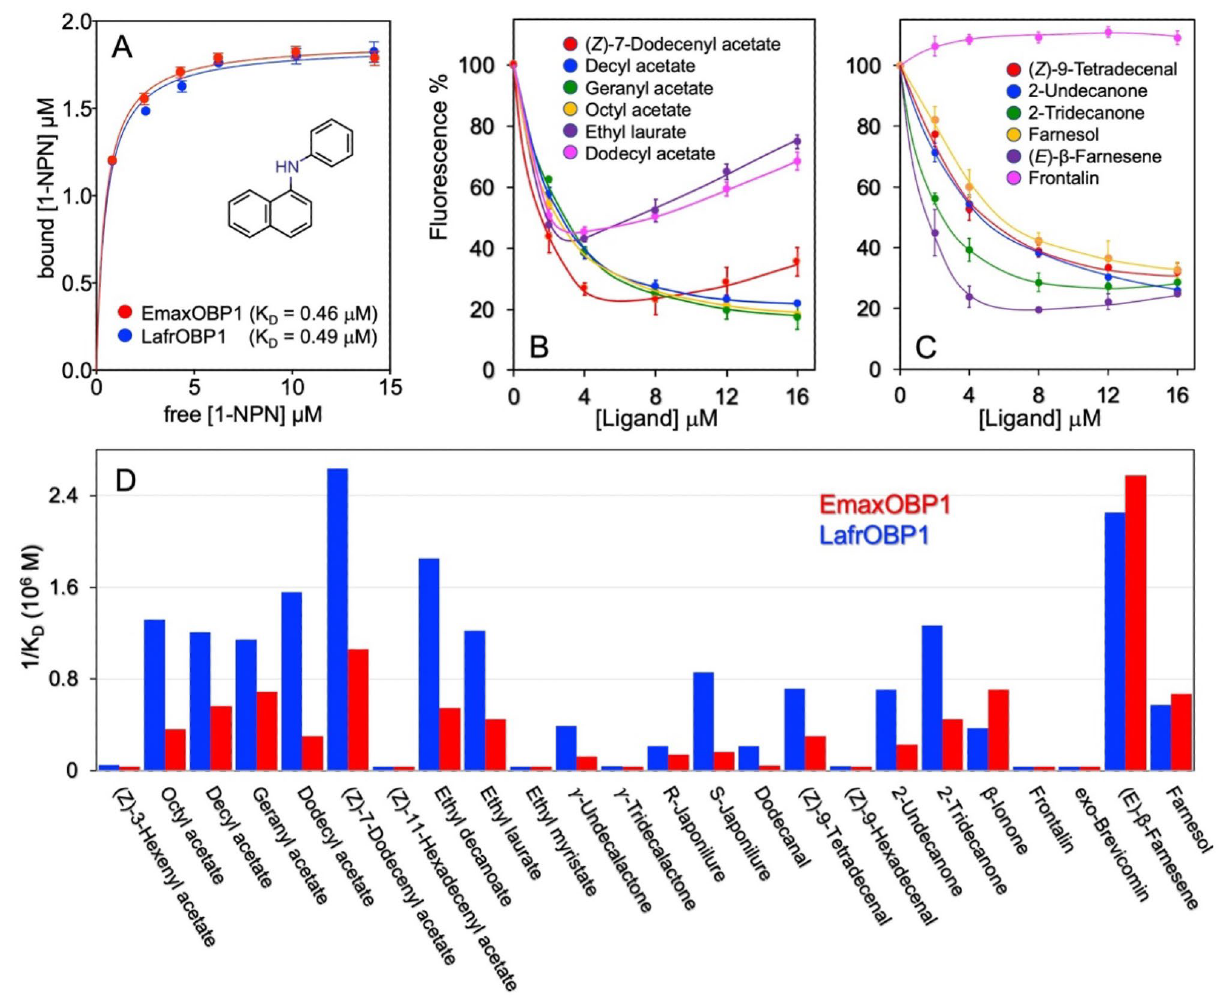
Figure 5. Binding of recombinant LafrOBP1 and EmaxOBP1 to the elephants’ pheromones and structurally related compounds. ( A ) Both proteins bound the fluorescent probe N-phenyl-1-naphthylamine (1-NPN), whose structure is reported as an inset, with strong and very similar affinities. ( B ) Binding of the pheromone ( Z )-7- dodecenyl acetate and few structurally related esters to recombinant LafrOBP1. The increase of the fluorescence at higher concentrations of ligand is due to formation of micelles by some amphiphilic ligands, which could entrap molecules of 1-NPN 33–35 . ( C ) Binding of representative compounds among the other tested chemicals. Interestingly, ( E )-β-farnesene was found to be a good ligand, despite its structural difference with the Asian elephant pheromone ( Z )-7-dodecenyl acetate. Instead, frontalin, a second Asian elephant pheromone, did not exhibit any affinity for the protein. ( D ) Graphical comparison of the affinities of selected ligands to the OBP1 of both elephant species. No major differences were observed in the binding spectra between LafrOBP1 and EmaxOBP1. In addition to the reported ligands, the following compounds did not exhibit significant affinity for neither of the two proteins: hexanal, octanal, decanal, ( Z )-11-hexadecenal, ( Z )-13-octadecenal, eucaliptol, p -cresol,